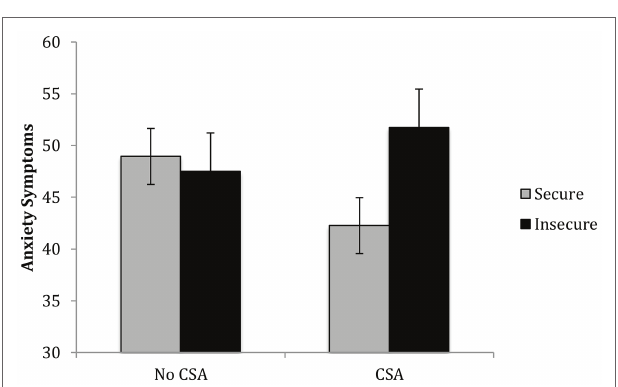
FIGURE 2 | Children’s CSA history and attachment interact in predicting their anxiety